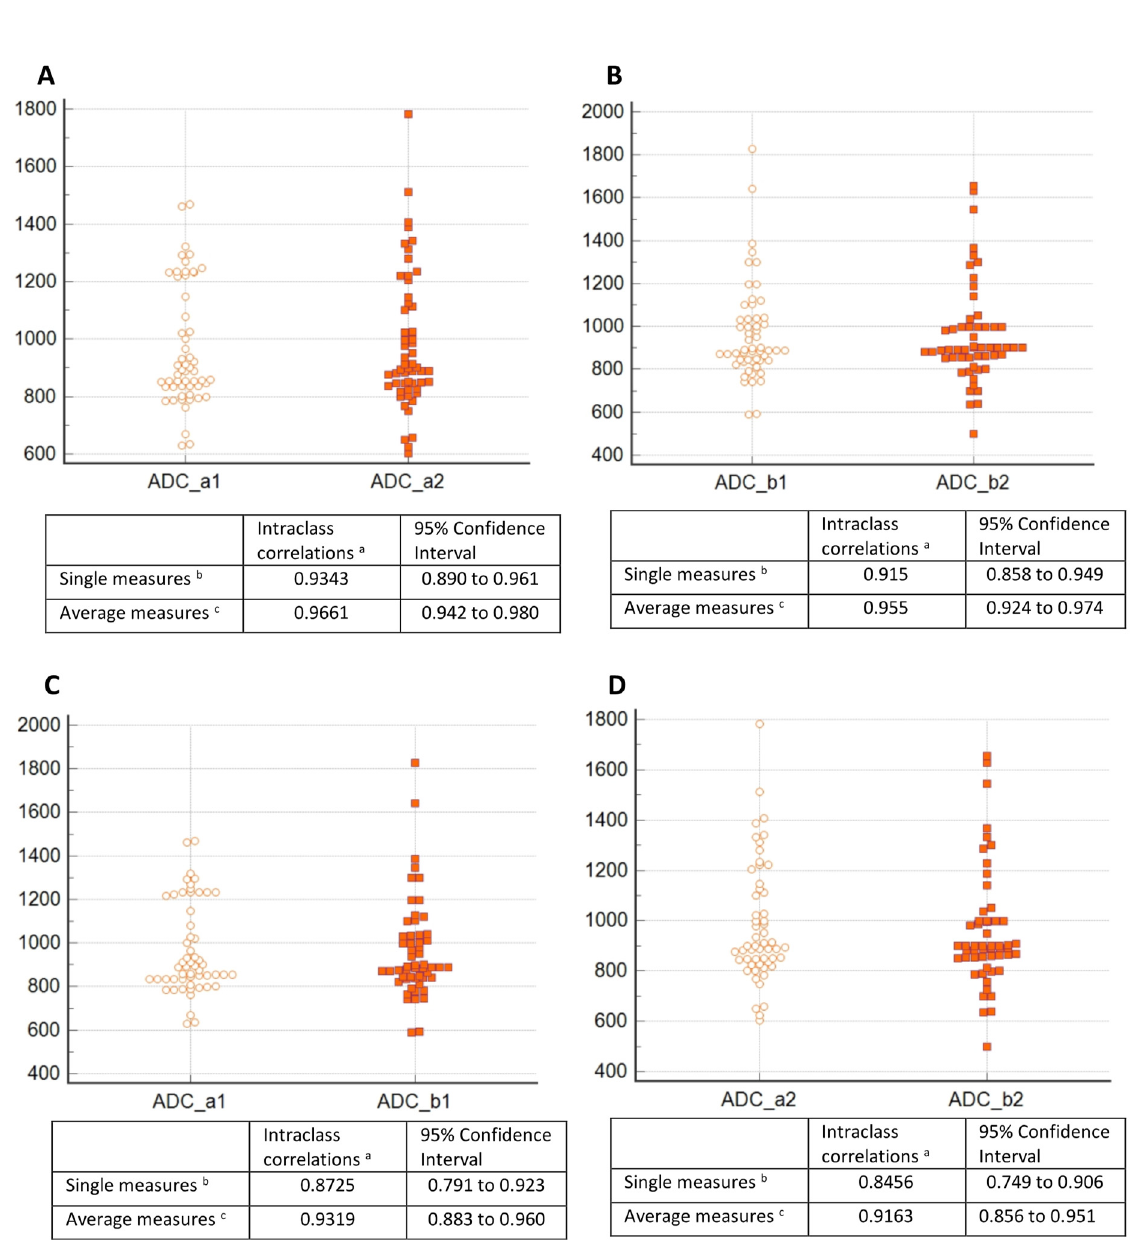
Figure 4. The interobserver agreement of the ADC measurements. A-concordance of the two measurements of the radiologist ( A ); B-agreement of the two measurements of the radiologist ( B ); ( C ) agreement of the first measurement between the radiologists ( A , B ); ( D ) concordance of the second measurement between the radiologists ( A , B ); a the degree of absolute agreement among measurements; b estimates the reliability of single ratings; c estimates the reliability of averages of k ratings.